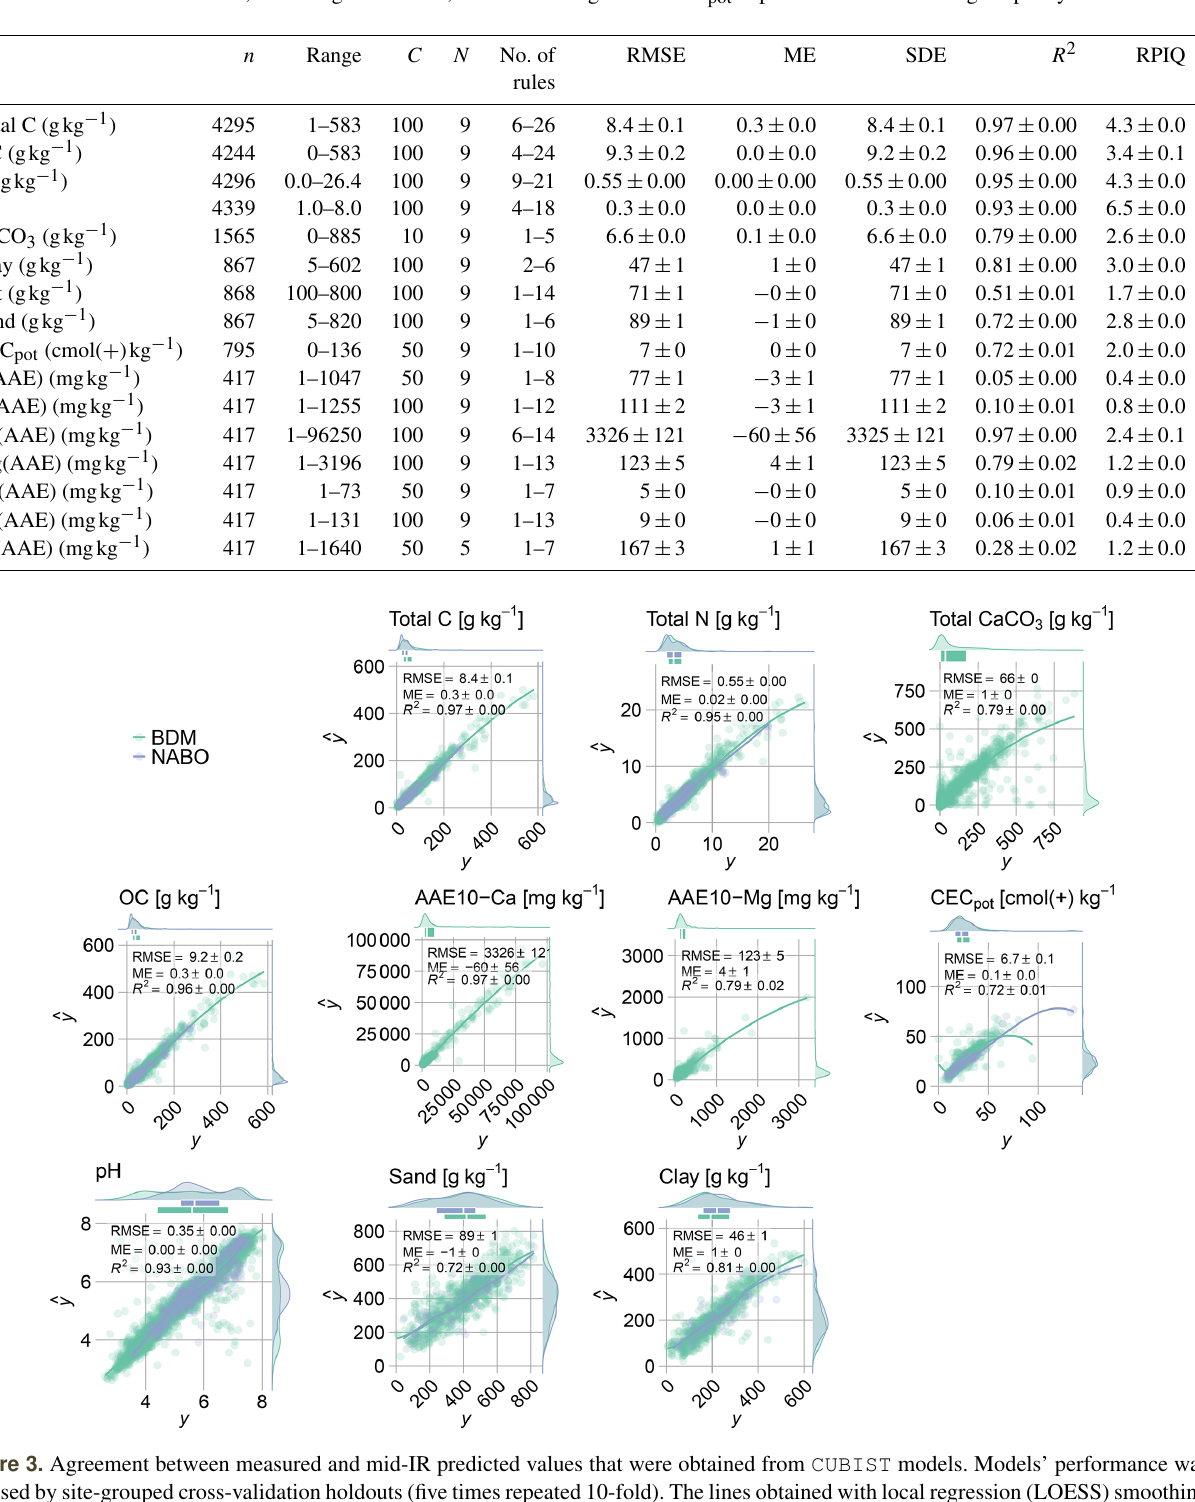
Table 2. Cross-validated mid-IR estimates of 18 soil properties derived from rule-based CUBIST models that were developed using all available data. The 10-fold cross-validation procedure was grouped by the site and repeated five times to achieve many test–train data combinations and provide a realistic model assessment with generalization. C and N denote the number of committees and neighbors for CUBIST . Total C is total carbon, OC is organic carbon, N is total nitrogen and CEC pot is potential cation exchange capacity.